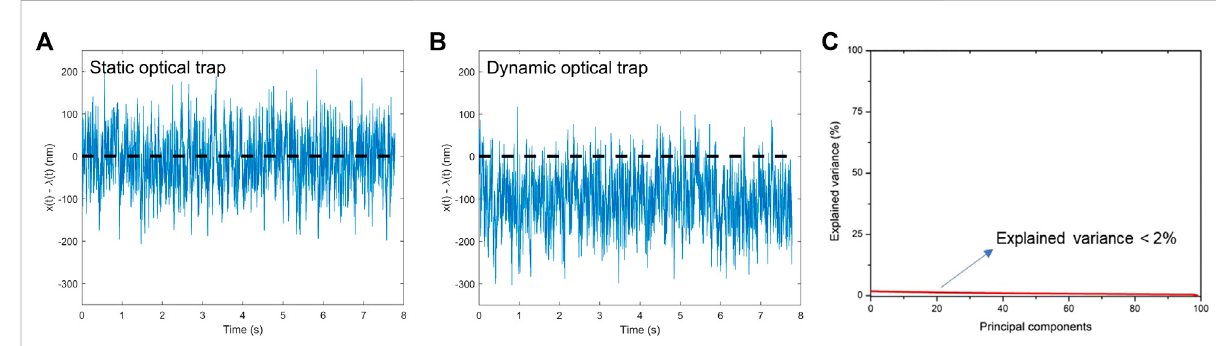
FIGURE 2 Stochastic trajectories for optically trapped colloidal particle. Simulation parameters: particle radius R = 1 μ m, temperature T = 295 K, viscosity of water η = 10 − 3 Pa.s, trap stiffness κ x = κ y = 1 pN. μ m -1 . (A) Static optical trap; (B) Dynamic optical trap with pulling speed υ = 10 μ m.s -1